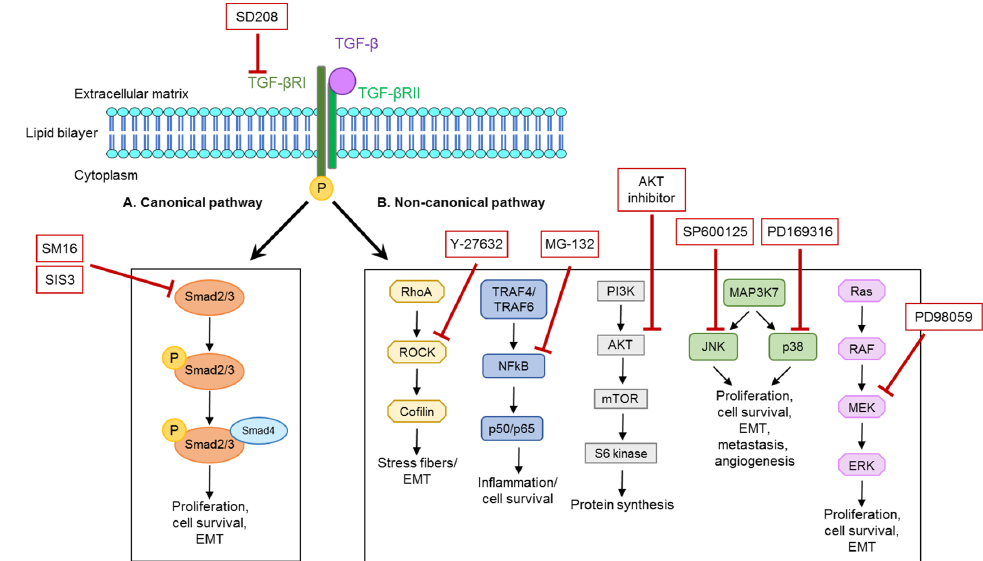
Figure 1. Illustration of canonical and non-canonical TGF- β pathways and the respective inhibitors used for the blockade of separate parts of the pathways. TGF- β signaling is intracellularly mediated via a canonical, SMAD2- and SMAD3-dependent pathway or different non-canonical pathways, which signal via different routes, namely the Rho-ROCK, NFkB, PI3K-AKT-mTOR, and MAP-kinase pathways via JNK or p53 and Ras-Raf-MEK-ERK. Each signaling arm facilitates different reactions in the cell, such as proliferation, cell survival, epithelial-to-mesenchymal transition (EMT), or protein synthesis (adapted from